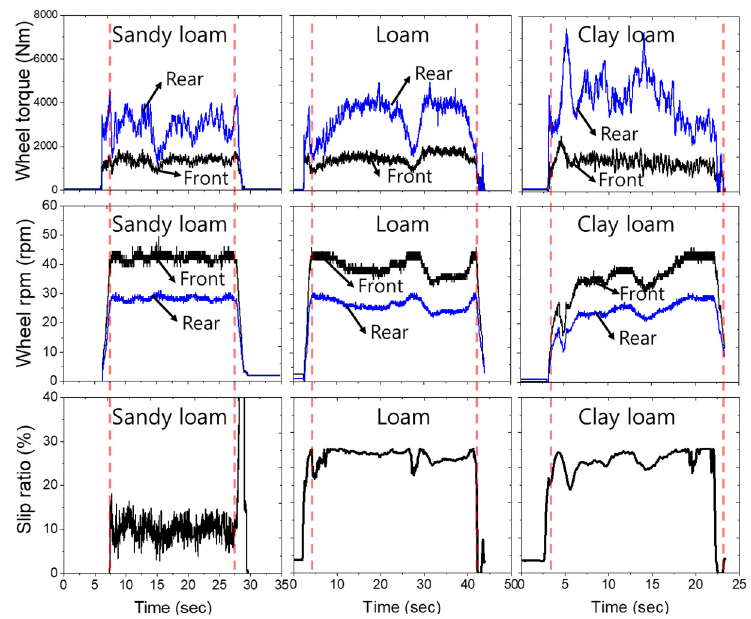
Figure 8. Field measurements results of wheel axle load and slip ratio under various field sites.